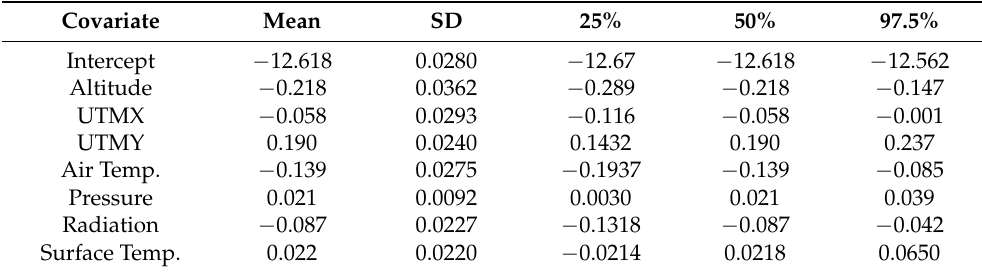
Table 4. Regression coefficients of meteorological and geographical covariates.